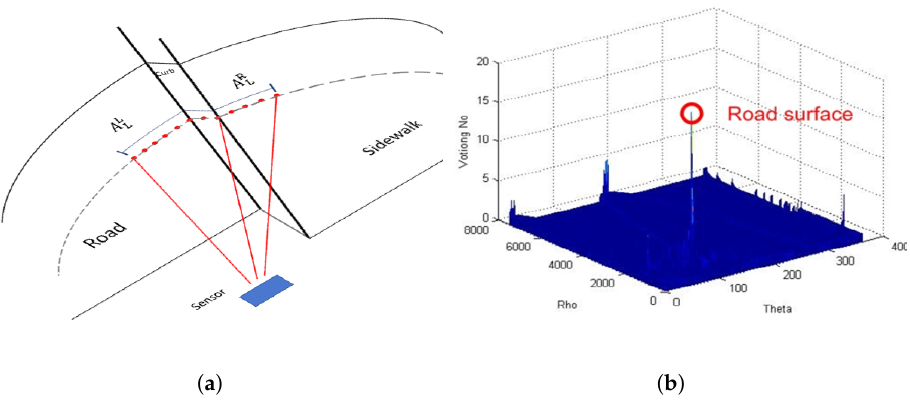
Figure 14. Geometric features: ( a ) Smooth arc length feature on LiDAR pointclouds. ( b ) Accumulator of the Hough transform used for road curb detection presented in [5].